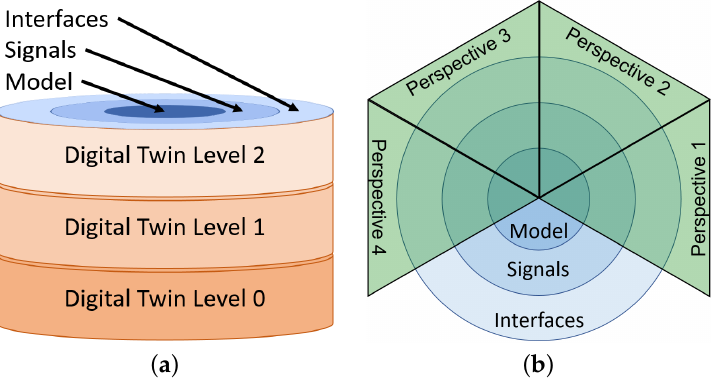
Figure 6. Multi-perspective concept. [Source: Own figure]. ( a ) Side view ; ( b ) Top view.